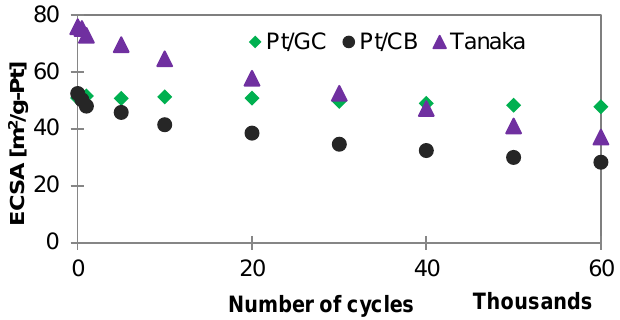
Figure 3. Comparison of support stabilities (in terms of ECSA survival rate) of the catalysts during potential cycle tests between 1.0 and 1.5 V vs. RHE in 0.5 M H 2 SO 4 electrolyte at 500 mV/s voltage scan rate at 25 °C.